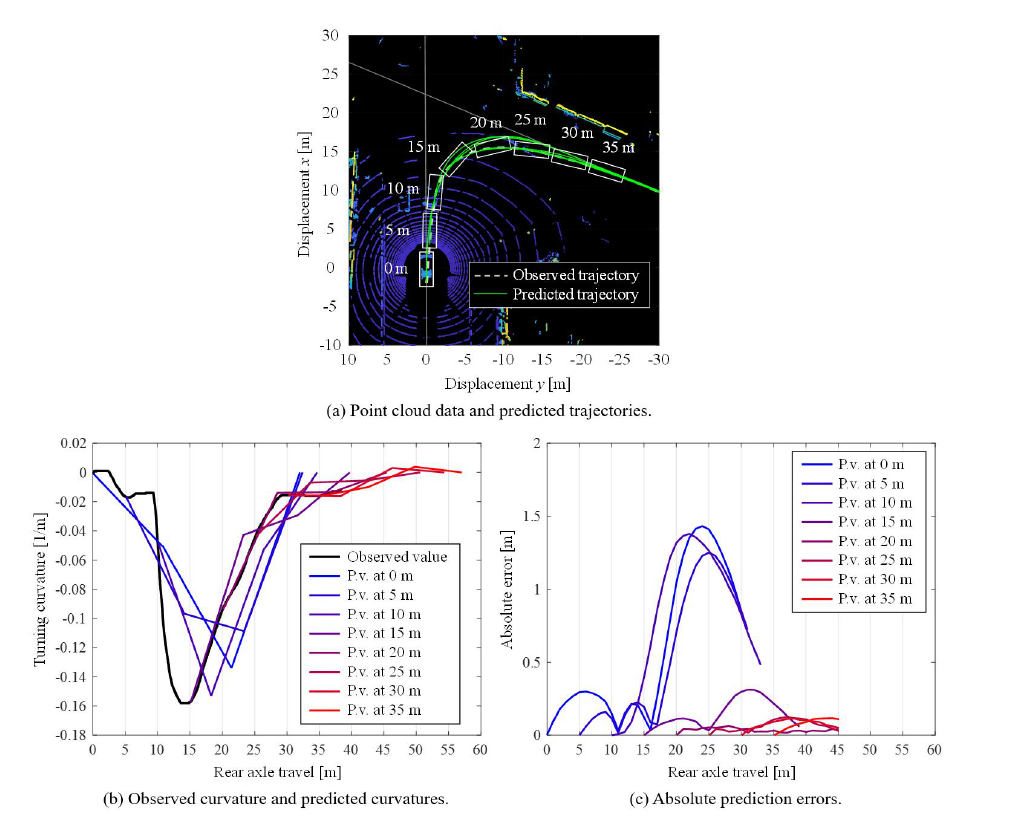
Figure 12. Prediction results with estimated distance parameter ˆ d pre from experiment at intersection ID 2-2.